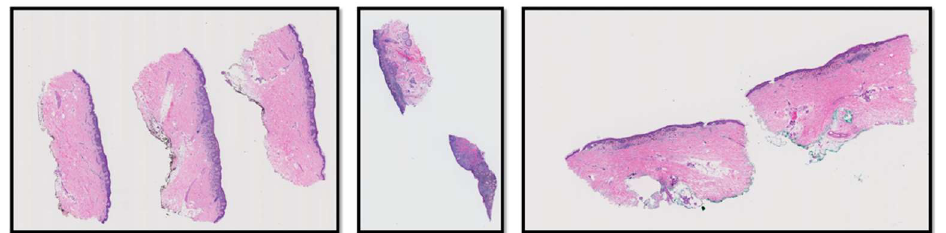
Figure 1. Three examples of WSIs in the M-Path dataset. The left image is a case with class IV diagnosis (invasive melanoma stage T1a), the middle image is a case with class V diagnosis (invasive melanoma stage ≥ T1b), and the right image is a case with class IV diagnosis (invasive melanoma stage T1a).